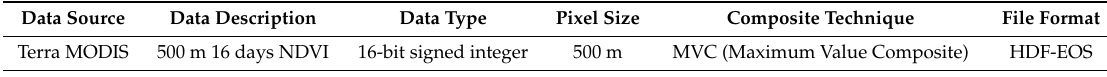
Table 2. MODIS NDVI products (MOD13A1)